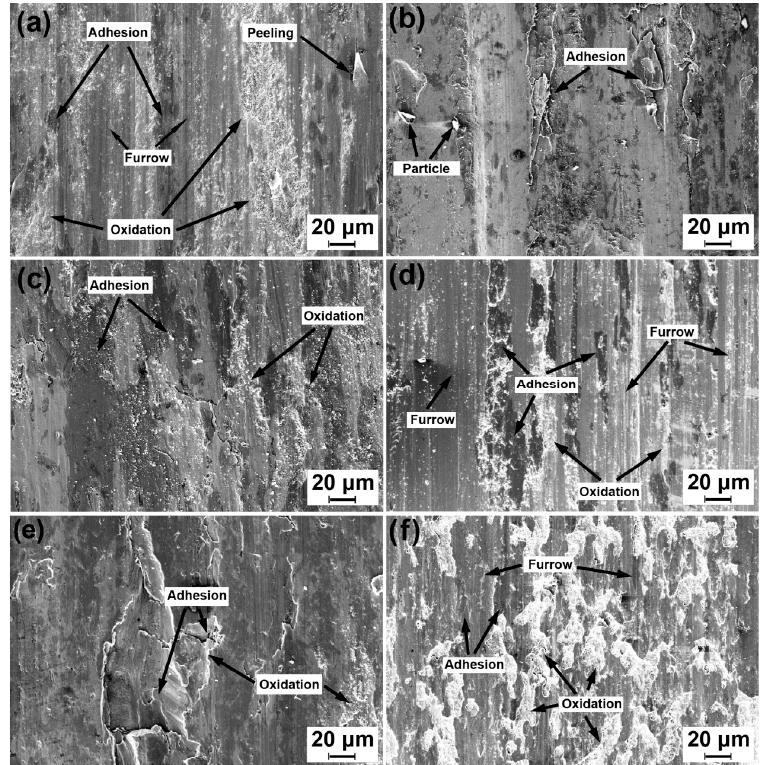
Figure 7. SEM micrographs of the worn surface of the ductile iron and carbon steel wheels under a normal load of 50 N at di ff erent sliding velocities: ( a ) D’, 6.3 × 10 4 mm / min, ( b ) S, 6.3 × 10 4 mm / min, ( c ) D’, 9.42 × 10 4 mm / min, ( d ) S, 9.42 × 10 4 mm / min, ( e ) D’, 12.54 × 10 4 mm / min, and ( f ) S, 12.54 × 10 4 mm /